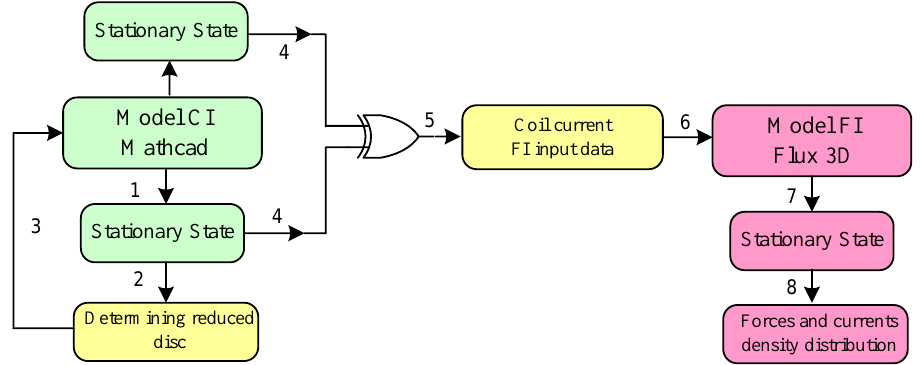
Figure 10. Block diagram of the hybrid circumferential-field model (CI-FI) with current extortion (1-8 - sequences of execution of blocks).